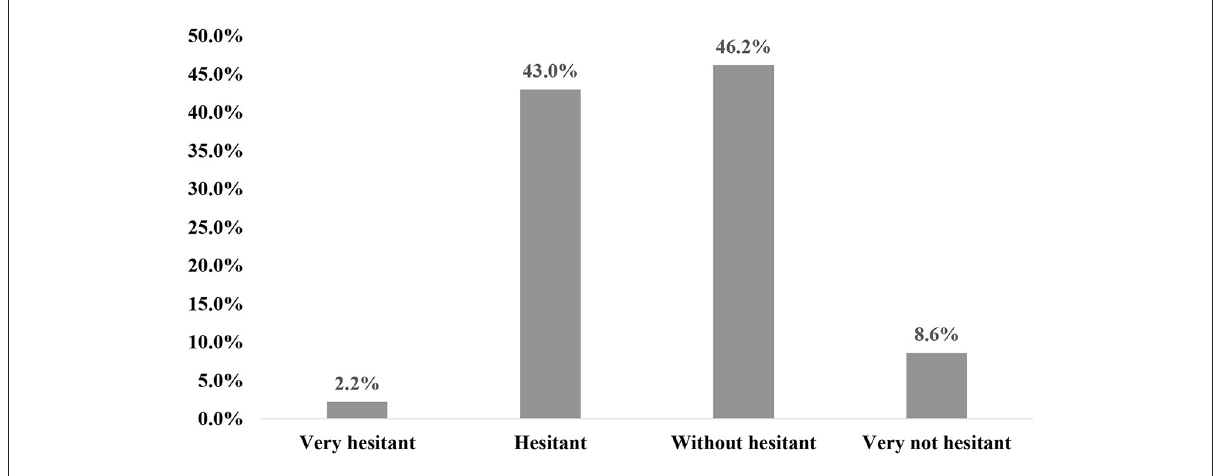
FIGURE1 COVID-19 vaccine hesitation ( n =